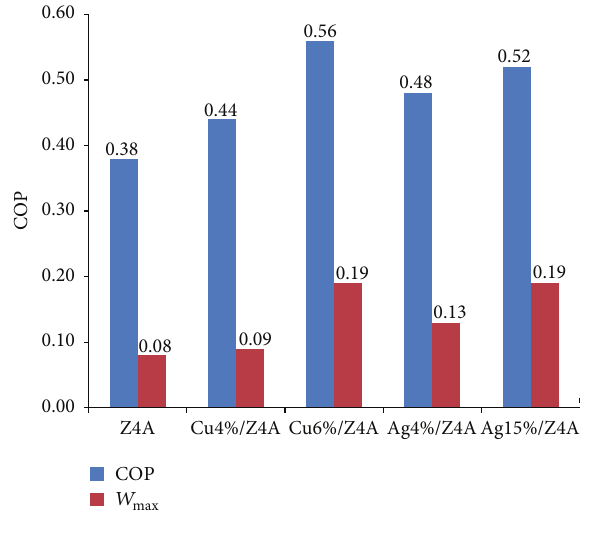
Figure 10: Effect of zeolite type